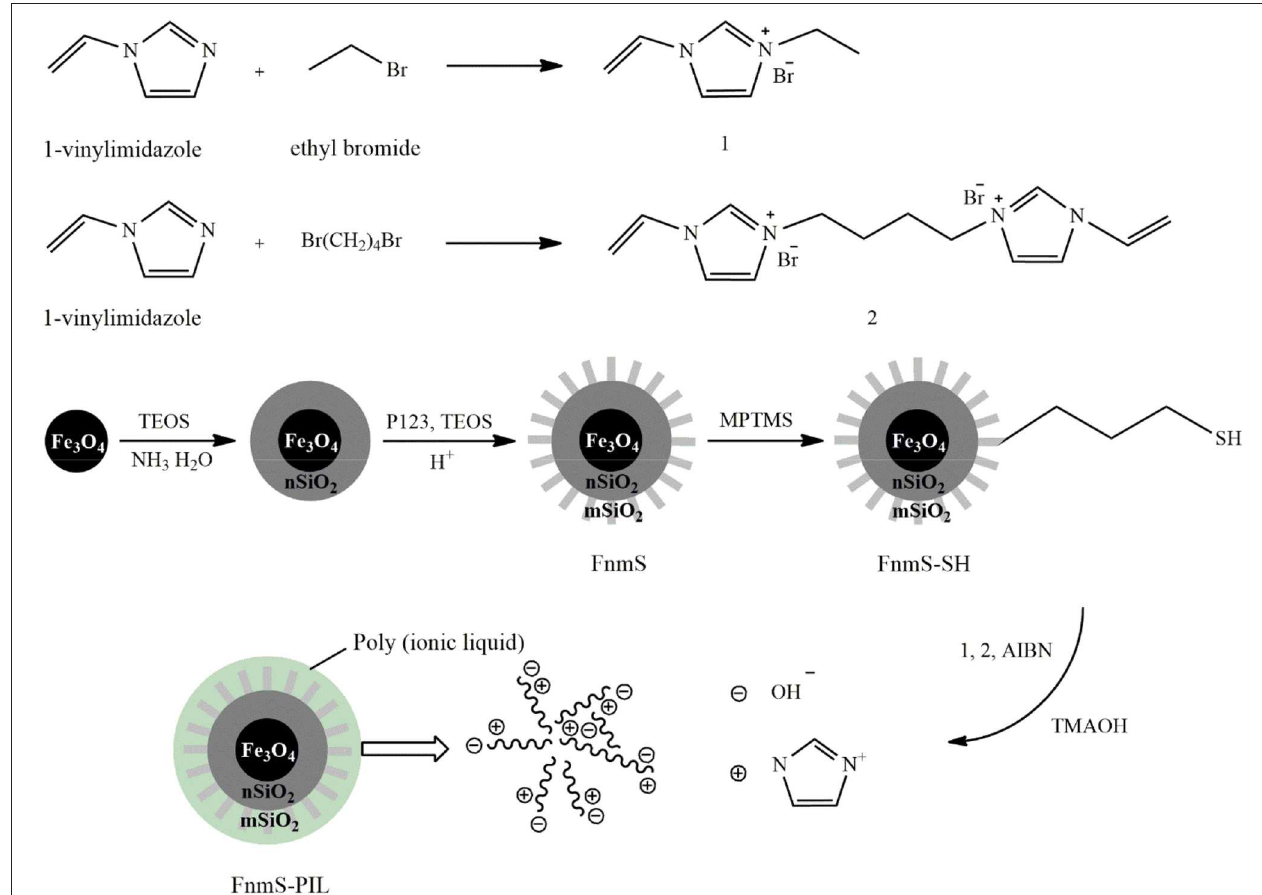
FIGURE 6 | The synthesis process of Fe 3 O 4 @SiO 2 @SBA-15-BPIL [Redrawn from Zhang H. et al.